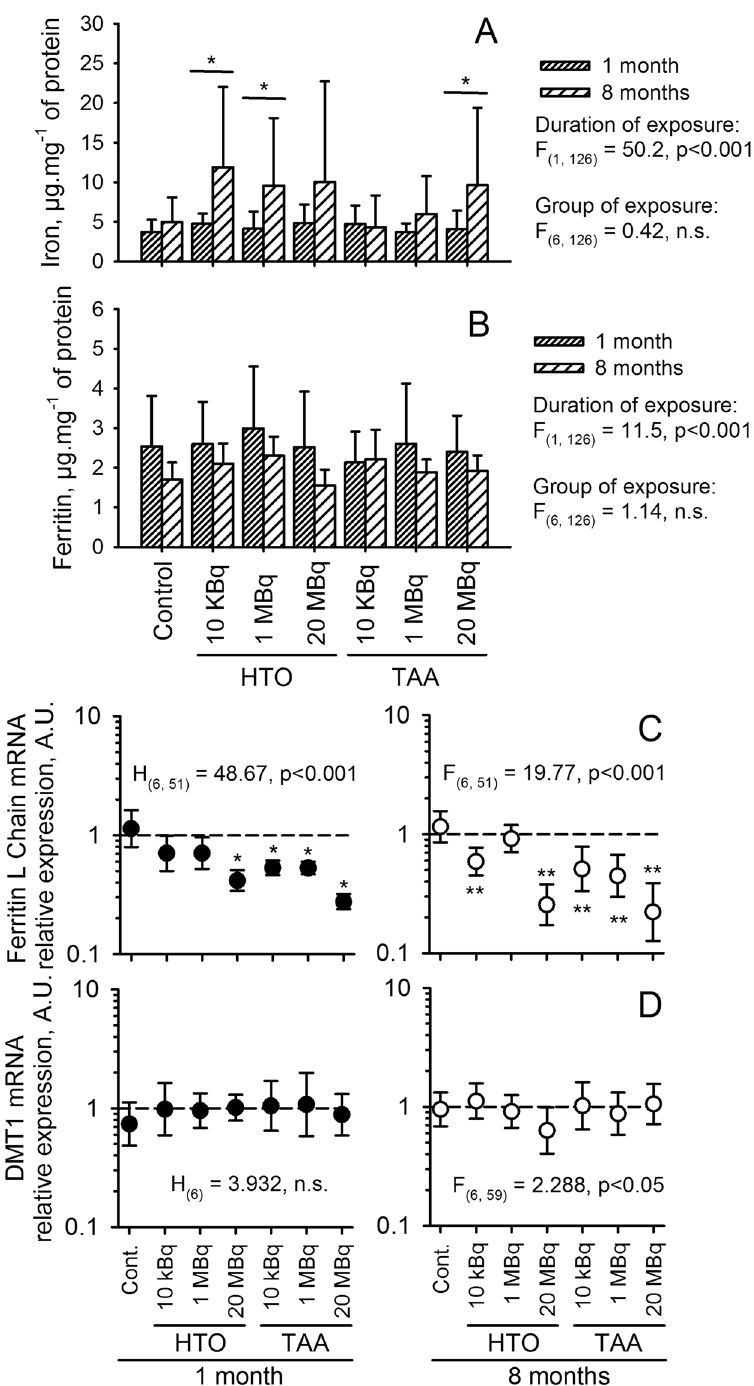
Figure 8. Iron metabolism in the intestine. ( A ) Iron concentration and ( B ) ferritin concentration in intestinal mucosa extracts, expressed as a mean ± SD of ten animals per group. For iron concentration ( A ), a two-way anova analysis showed a significant difference with the duration of exposure (which relates to an age effect) (F (1, 126) = 50.2, p > 0.001) but not with the group of exposure (F (6, 126) = 0.42, n.s.). For the ferritin concentration ( B ), difference according to the duration of exposure is significant (Age-related effect) (F (1, 126) = 11.5, p > 0.001), but not with the group of exposure (F (6, 126) = 1.14, n.s.). Differences between 1 and 8 months of exposure within each group of exposure, tested with a multiple comparison method, are indicated for * p < 0.05 and ** p < 0.001. ( C , D ) mRNA expression of ferritin L ( C ) and DMT1 ( D ) after either one (left panel) or eight months (right panel) of exposure. Results are presented a mean ± SD of ten animals and results from the one-way anova or the anova on ranks analysis are indicated for each graph. Significant differences with the control, using a multiple comparison procedure are indicated for * p < 0.05 and ** p < 0.001. Since the control group served as the reference for the relative gene expression at each duration of exposure, it was not possible to compare data from one-month exposure with data from eight-month